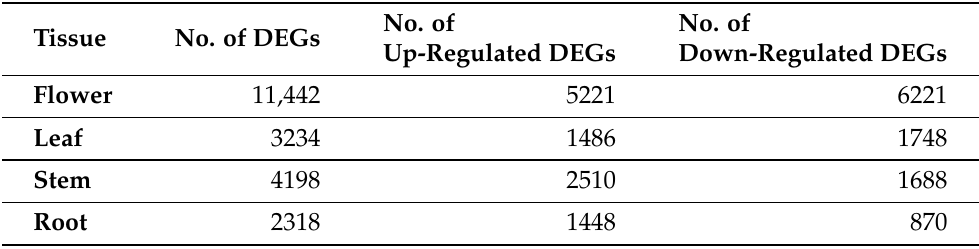
Table 1. Numbers of differentially expressed genes (DEGs) in four tissues based on the comparison of the cultivars Zhongshuang11 (ZS11) against Zhongyou821 (ZY821). Up-regulated and down- regulated DEGs are defined as log 2 fold change >2 and log 2 fold change < − 2 and an adjusted p -value threshold of 0.05,